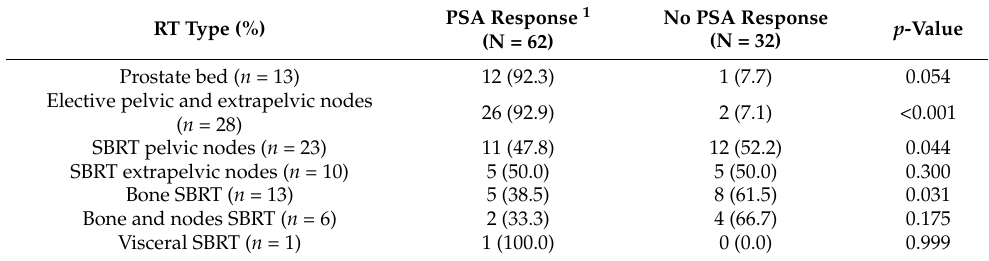
Table 5. PSA response at 3–6 months post-RT in relation to the treatment received.